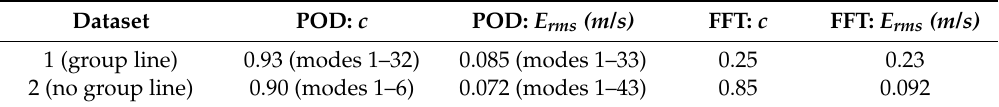
Figure 5. Average correlation coefficient ( c ) between POD reconstructed orbital velocity time series and wave buoy orbital velocity time series for each (1 to n ) mode reconstruction (black line) and average correlation coefficient between FFT-based dispersion curve orbital velocity time series and wave buoy time series (red dashed line). Correlation coefficients are averaged over all available buoys. ( a ) shows dataset 1 and ( b ) shows dataset 2. Table 2. Correlation coefficient ( c ) and E rms for both wave retrieval methods: proper orthogonal decomposition (POD) and dispersion filtering (FFT) for each dataset. For POD, the peak c and minimum E rms are provided with the mode selection (modes 1- n ) shown